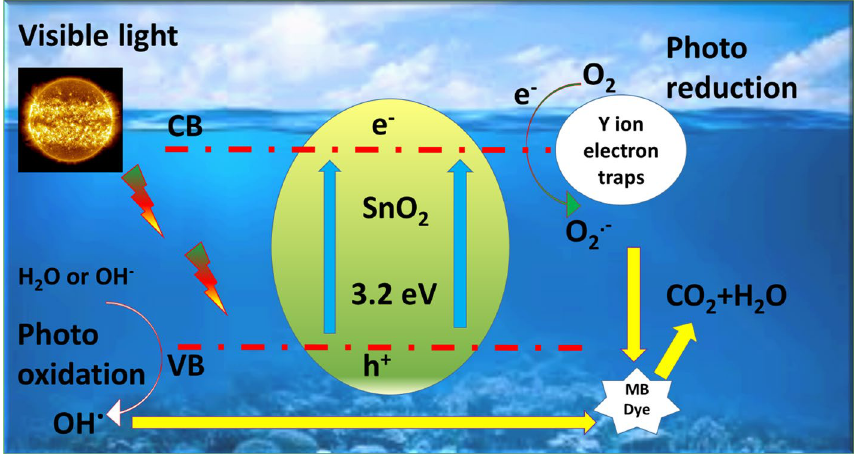
Fig. 14 The possible mecha- nism of MB dye degradation for 4% Y-doped SnO 2